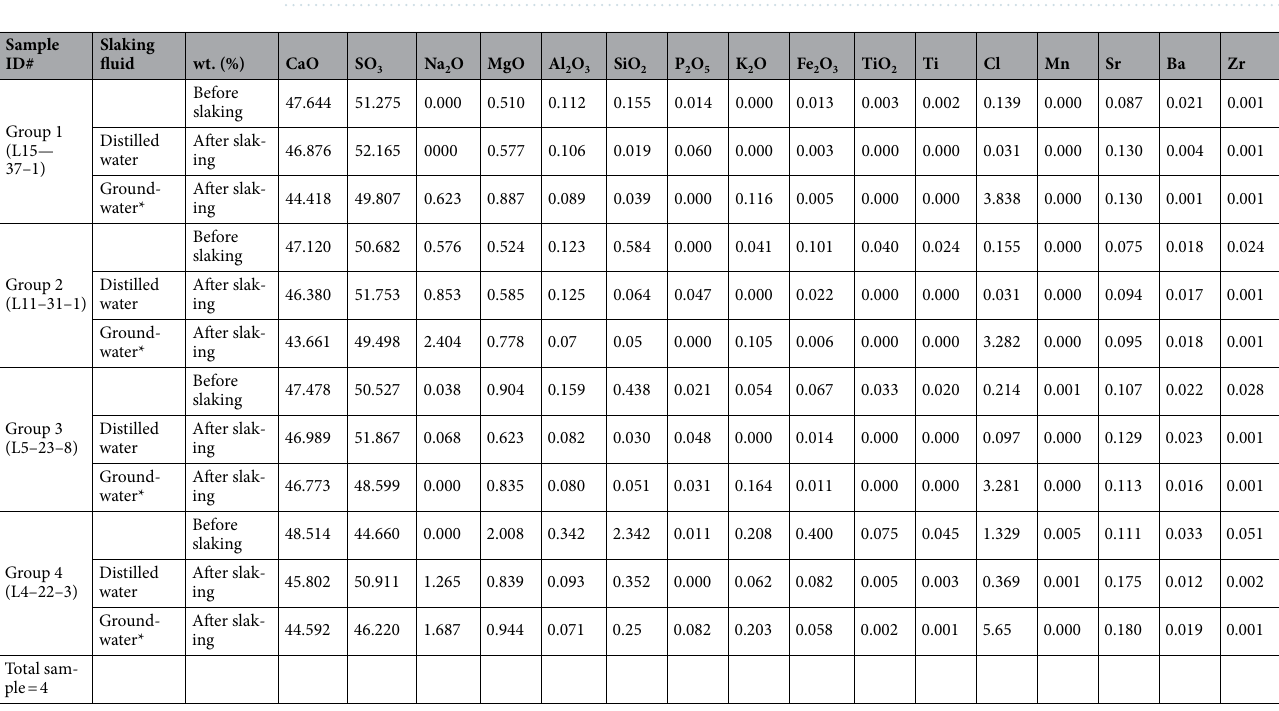
Table 1. Chemical composition of representative evaporitic samples from group 1 to 4 before and after slaking with distilled water and groundwater. *Groundwater specification: Groundwater level = 10–40 m, ◦ Temperature = 21.5–31.2 ( C), Salinity = 20,000–65,000 (ppm), pH = 7.14–9.45, TDS = 32,700–175,360 (ppm), EC = 28,100–274,000 (μ